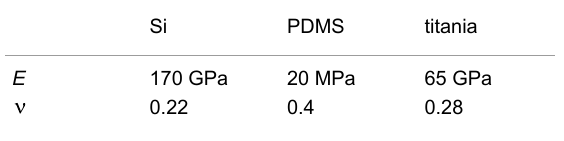
Table 2: Young’s modulus E and Poisson ratio used in FEA calcula-